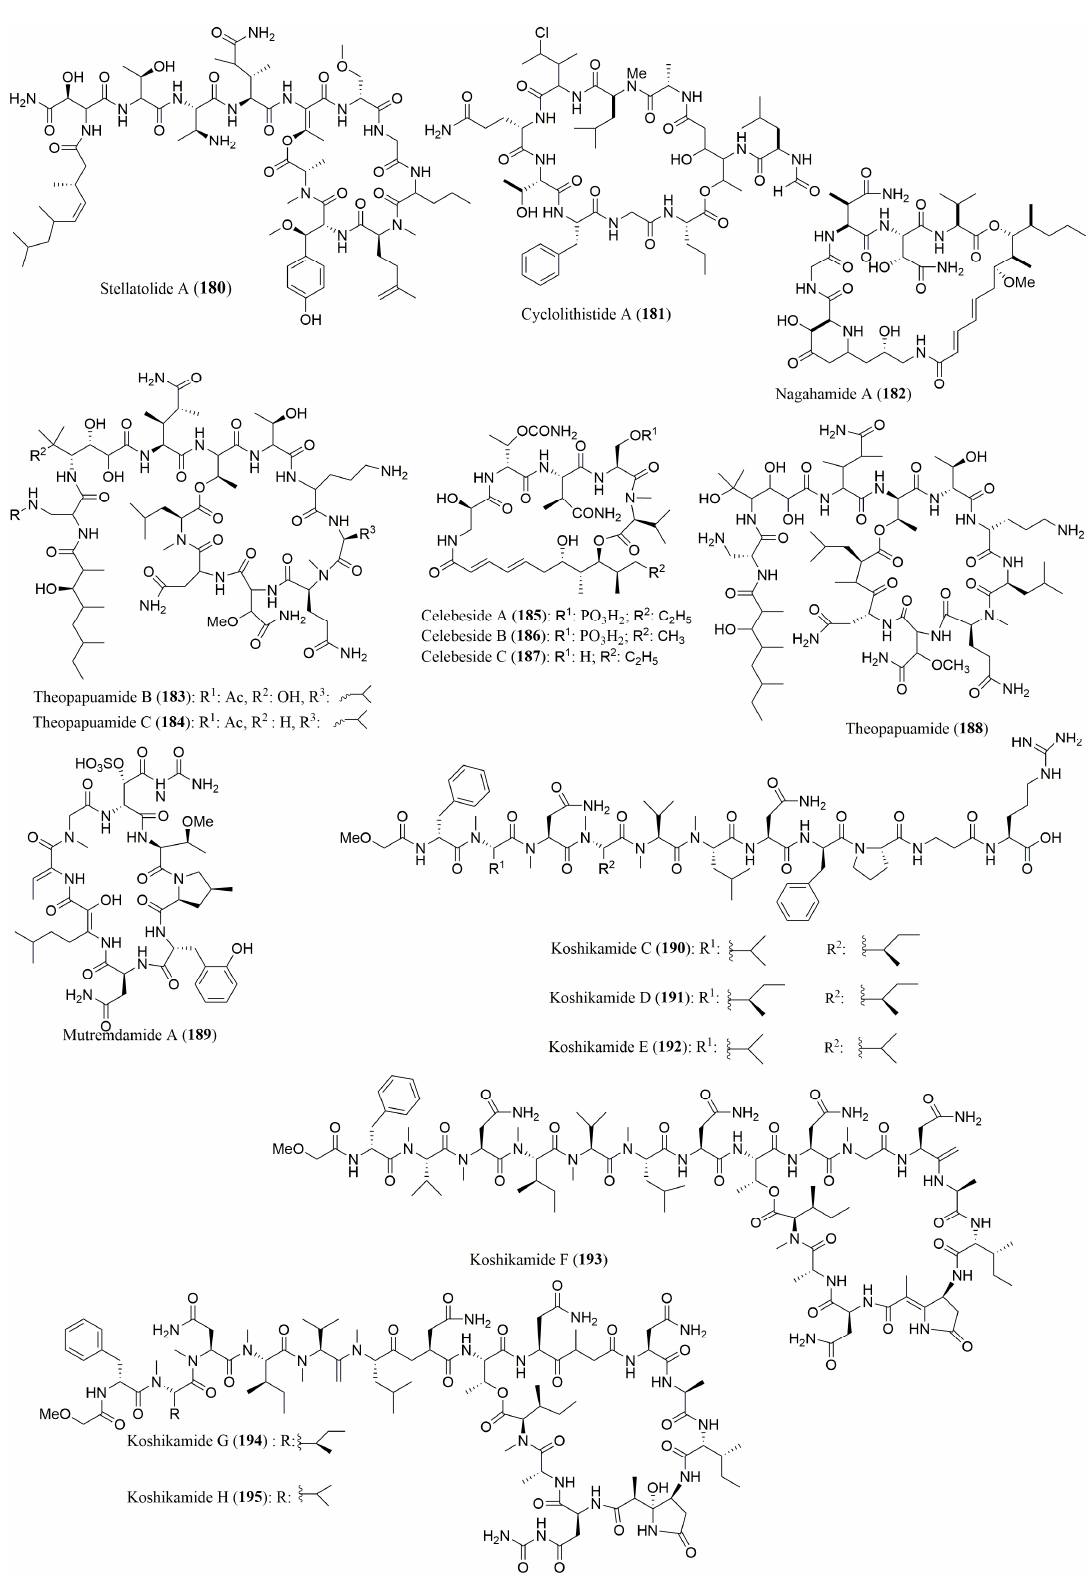
Figure 13. Structure of cyclic depsipeptides 180 – 195 , isolated from marine sponges.